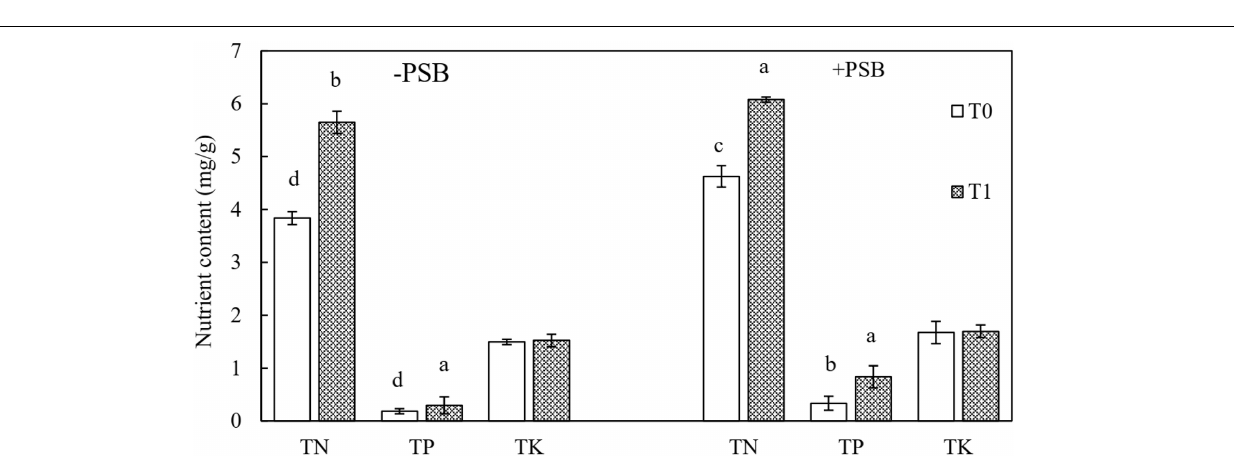
FIGURE 1 | Effects of rock phosphate (RP) and phosphate-solubilizing bacteria (PSB) on peanut (A) root and shoot dry weight (g plant − 1 ), (B) root and shoot length (cm), and (C) total leaf number (TLN) and total branch number (TBN). Treatments: T0, no additions, the control; T0P, with PSB inoculation only; T1, with RP amendment only; T1P, with RP and PSB. Values are the means of three replicates. Error bars represent ± standard deviation. Values sharing a common letter within the column are not significant at P < 0.05.